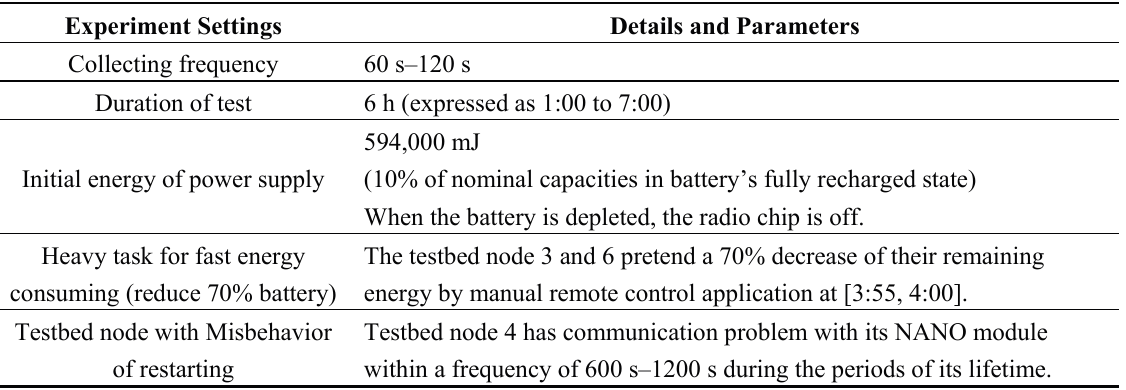
Table 11. Similar settings in three comparative experiments.